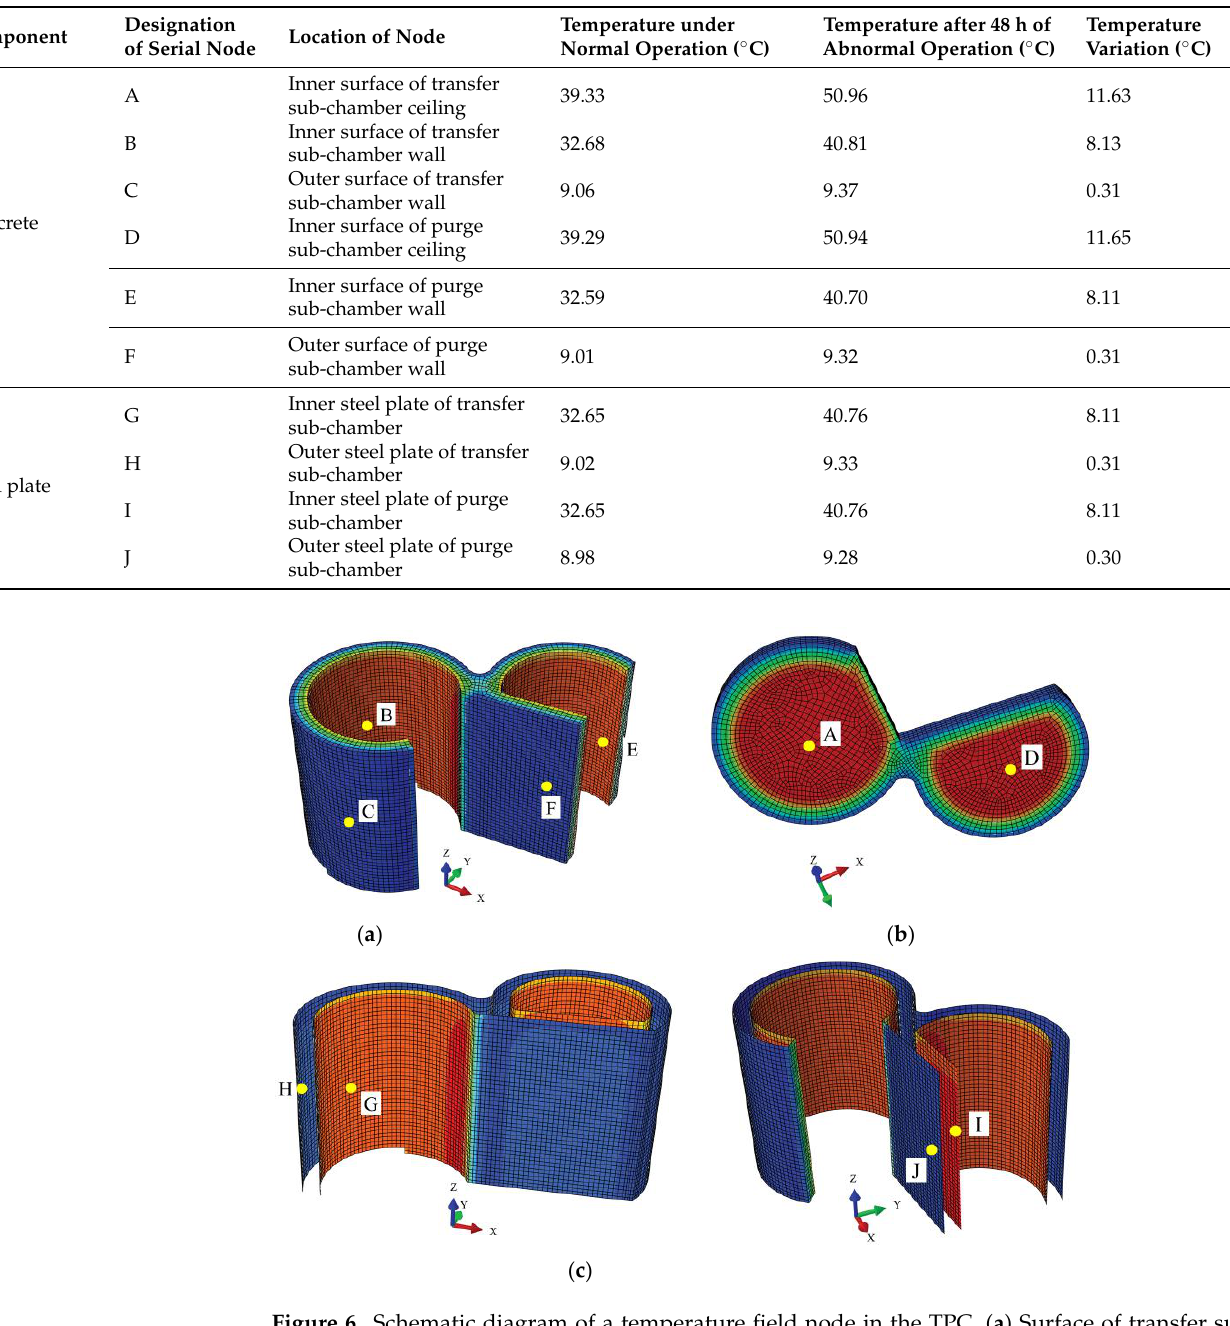
Table 2. Variation in the temperature field of the TPC during abnormal operation. (The location of nodes A–J are shown in Figure 6).